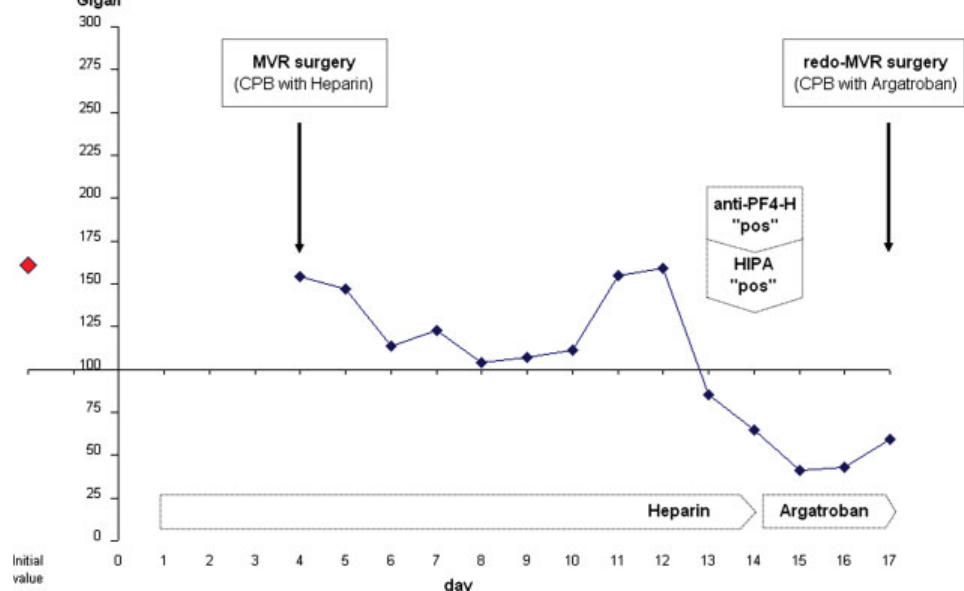
Fig. 1 Thrombocyte count (y-axis) in patient A with early left atrial thrombus formation 10 days after surgery. x-axis represents time line. Unfractioned heparin was started on the day of hospital admission as an intravenous application, because of atrial fi brillation. In the preoperative period, target partial thromboplastin time (PTT) was 60 – 80 seconds; intraoperatively, target ACTwas 400 seconds; and postoperatively, target PTTwas again 60 – 80 seconds. Time of PF4-H IgG-speci fi c ELISA and HIPA tests and time of redo-MVR surgery are indicated by arrows. Result for ELISA was 2.09 OD, for HIPA 4 of 4 cells (details in Clinical Summary). Argatroban infusion was started on day 13 after MVR surgery, with a target value of 1.0 ng/mL.